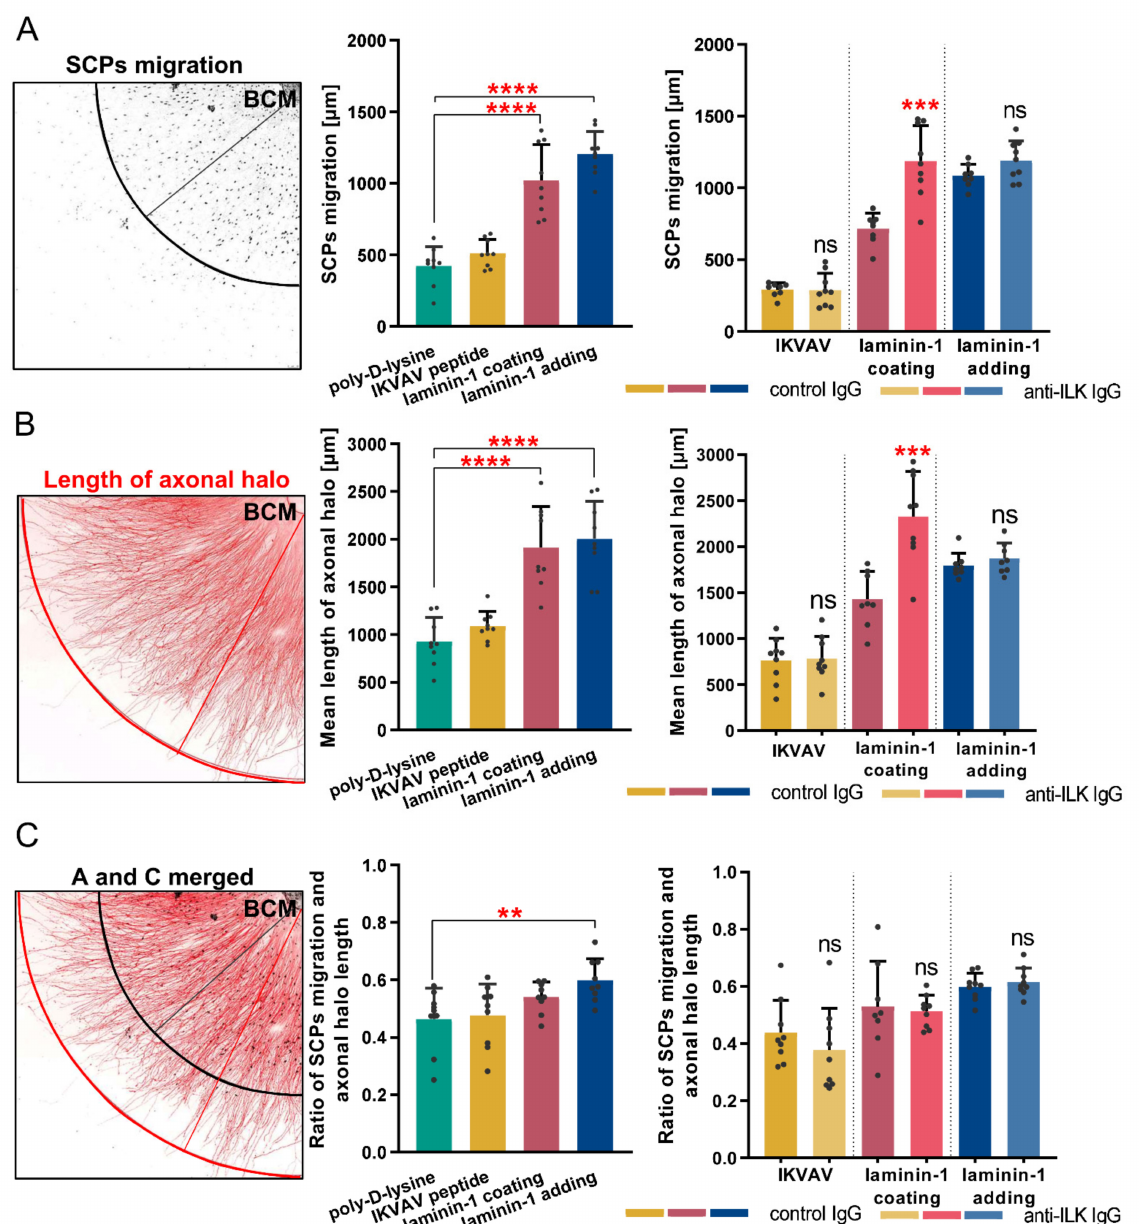
Figure 6. ILK does not play a role in laminin-1 mediated migration of Schwann cell precursors. DRG were cultured on a laminin-1-coated surface, with IKVAV peptide, or with laminin-1 for 48 h. Additionally, control or anti-ILK antibodies were added to the medium. Next, DRG were immunostained with anti-Sox10 and anti-NF-m antibodies to detect SCPs and DRG neurites, respectively. ( A ) The scheme of a part of DRG explant showing nuclei of SCPs and their distance of migration, and quantitative analysis of the impact of IKVAV and laminin-1 and disruption of the ILK’s function on the distance traveled by SCPs from the border of BCM; p ≤ 0.001 (***); p ≤ 0.0001 (****); ns—not significant; ( n = 9); ( B ) The scheme of a part of DRG explant showing DRG axons and the length of their halo, and quantitative analysis of the impact of IKVAV and laminin-1 and disruption of the ILK’s function on the length of axonal halo measured from the border of BCM to the tips of the growth cones; p ≤ 0.001 (***); p ≤ 0.0001 (****); ns—not significant; ( n = 9); ( C ) The scheme showing merged A and B schemes. Quantitative analysis of the impact of IKVAV and laminin-1 and disruption of the ILK function on the ratio between distance traveled by SCPs and length of DRG axonal halo; p ≤ 0.01 (**); ns—not significant; ( n = 9). Four sides of each DRG were taken for analysis and then averaged. Individual points represent averaged values obtained from the analysis of each DRG. All bar charts show mean ±